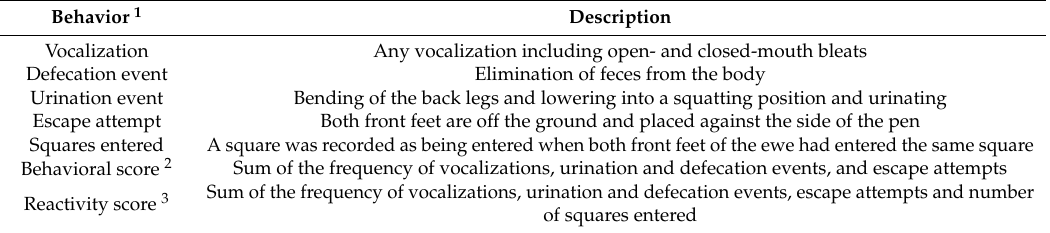
Table 1. Description of behaviors measured in the open-field and visual isolation